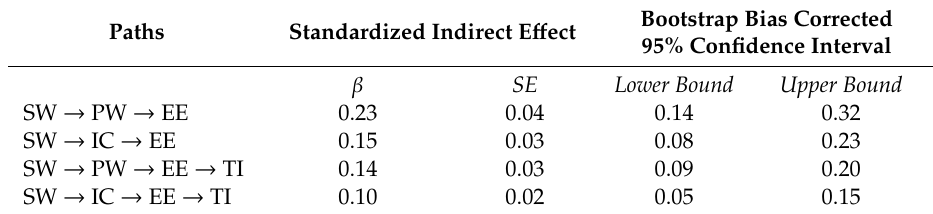
Figure 2. Structural model with standardized path estimates. Note: SW = supervisors’ workaholism; PW = perceived workload; IC = interpersonal conflict; EE = subordinates’ emotional exhaustion; TI = subordinates’ turnover intention; * p < 0.001. Table 2. Indirect relations for the structural model.